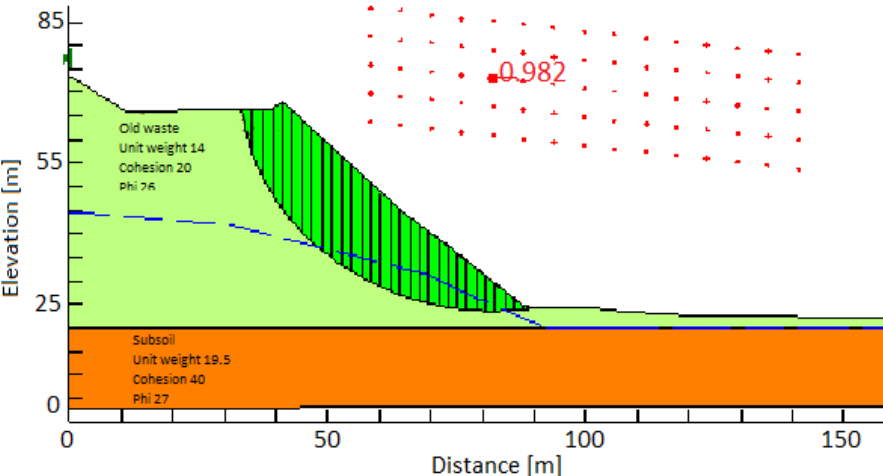
Figure 5. Slope stability analyses for a bare slope, using limit equilibrium method (LEM) indicating low value of FOS. Appl. Sci. 2020 , 10 , x